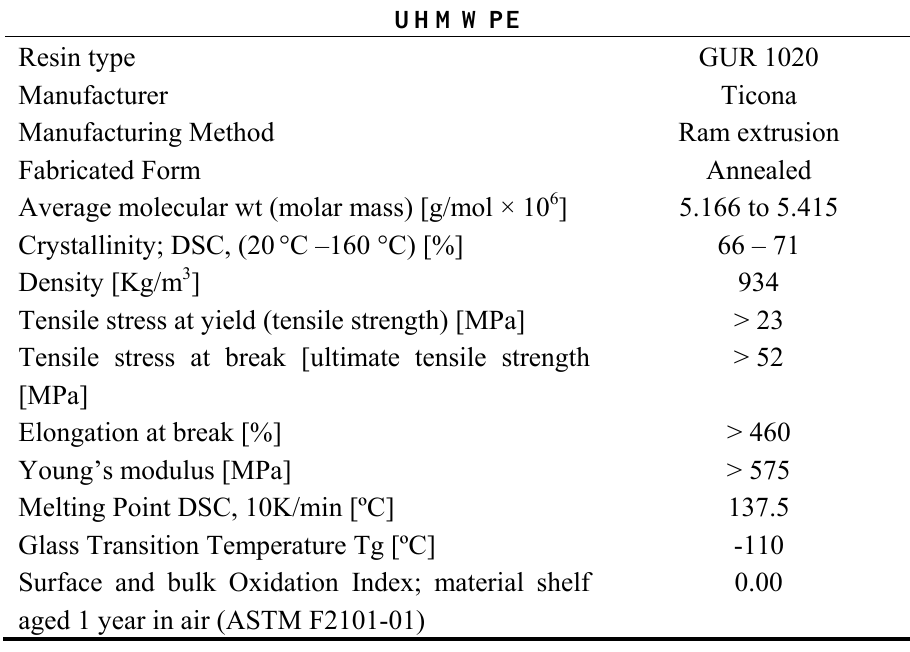
Table 2. Material properties of UHMWPE bar stock based on data sheet from